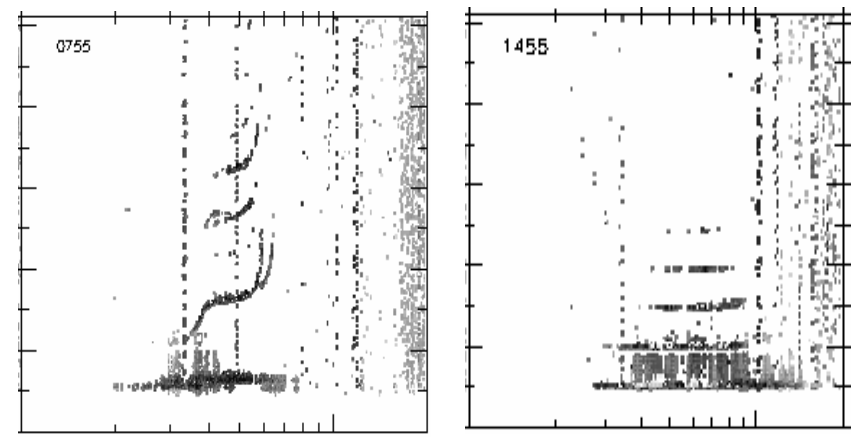
Fig. 3b. Ionograms recorded at 07:35 (left) and 14:55IST (right) on 18 June 2007. (1) Sample ionogram showing the presence of strong E sq (left). (2) Sample ionogram revealing the presence of blanketing E s (right).